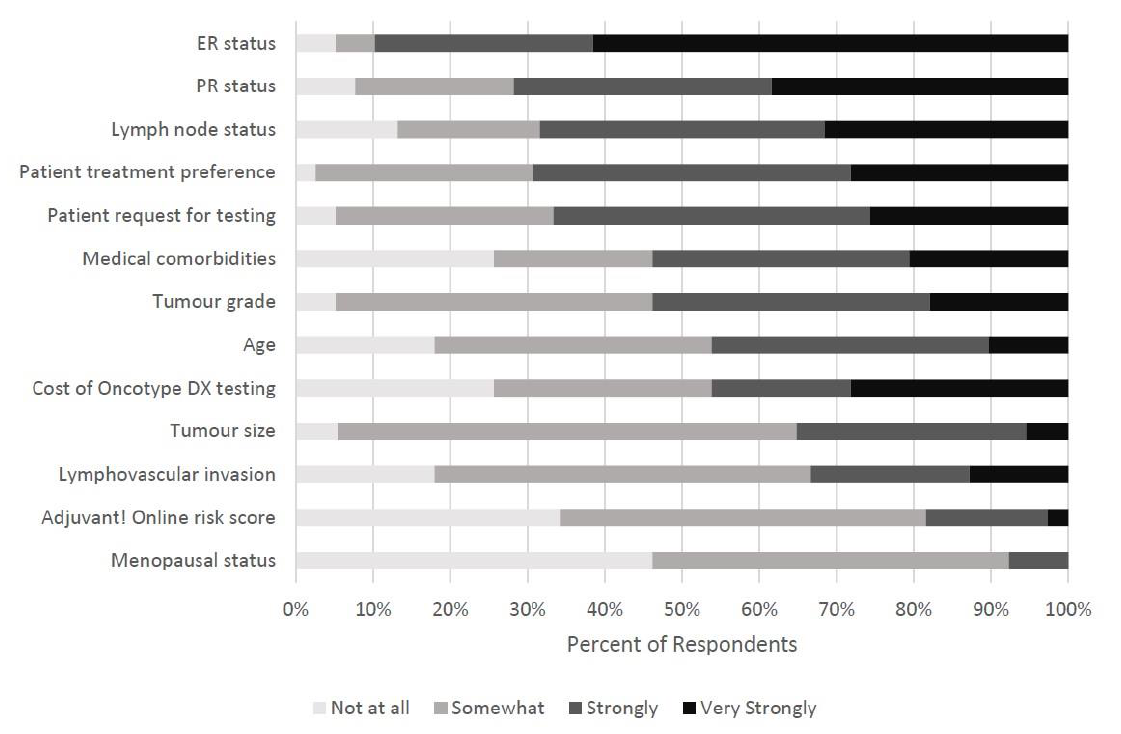
Figure 1. Survey results for questions related to how strongly the respondents felt the following factors influence their use of ODX.